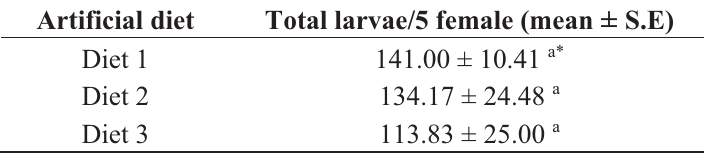
Table 2. Average number of larvae L. africanus in three artificial